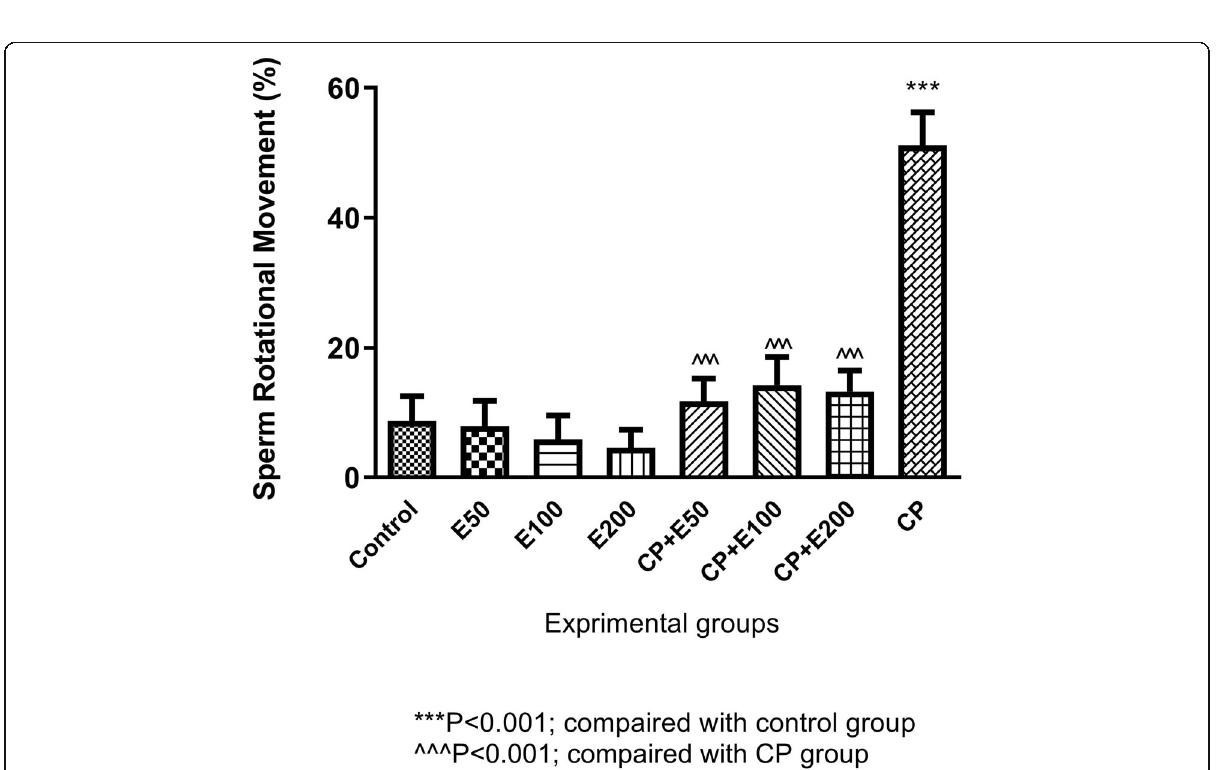
Fig. 4 The effect of Allium atroviolaceum L. extract (E) on sperm rotational movement in cyclophosphamide (CP)-treated